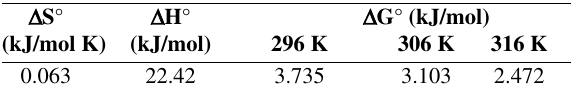
Table 2. Thermodynamic parameters for MG adsorption onto un- treated WGT at various temperatures; (94 mg/L, 100 mL, 4 g,